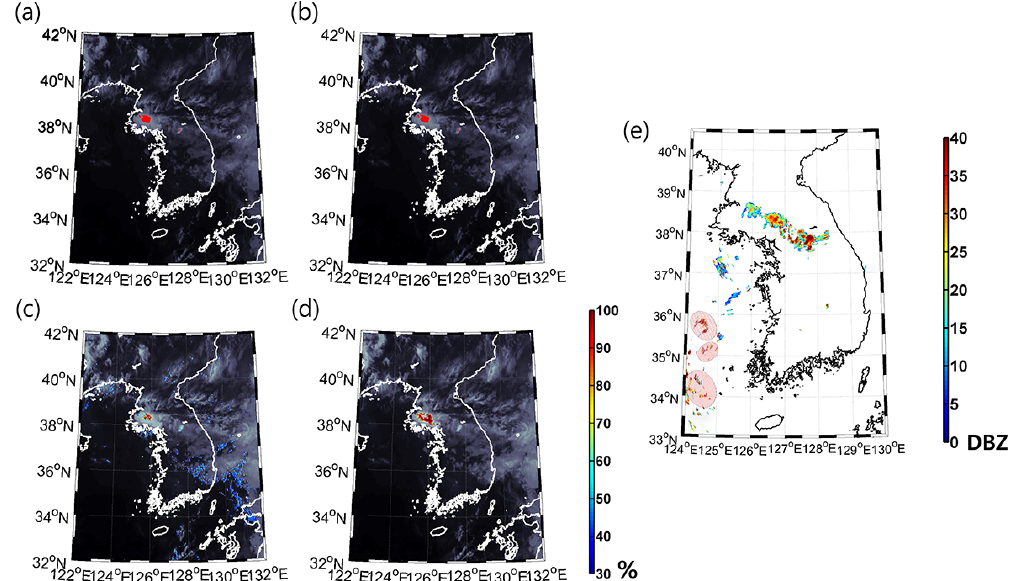
Figure 12. Deterministic CI detection map derived by DT, RF, probabilistic RF, and LR on 24 July 2016 at 14:50 (UTC): (a) DT, (b) RF, (c) probabilistic RF, and (d) LR 10min before CI occurrence. Panel (e) is the 1.5km radar CAPPI image at 15:00 (UTC). The radar echoes above 35dBZ beyond the effective radius of radar are shaded with red